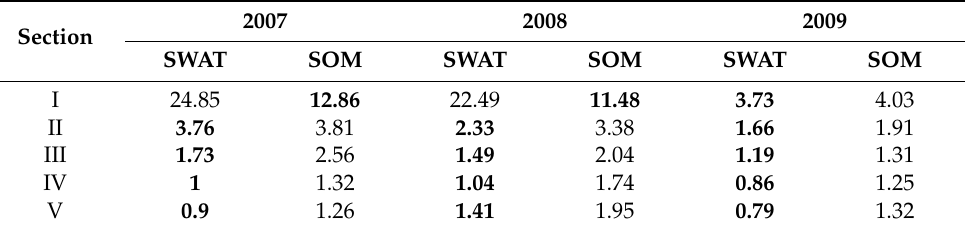
Figure 5. Flow duration curves (FDC) of Samho station in ( a ) 2007, ( b ) 2008, and ( c ) 2009. The plots are divided into five sections: I, flows over averaged-wet flow standard; II, flows between averaged-wet and normal flow standard; III, flows between normal and low flow standard; IV, flows between low and drought flow standard; and V, flows under drought flow standard. Table 4. RMSE values of SWAT and SOM in each section of FDC from 2007 to